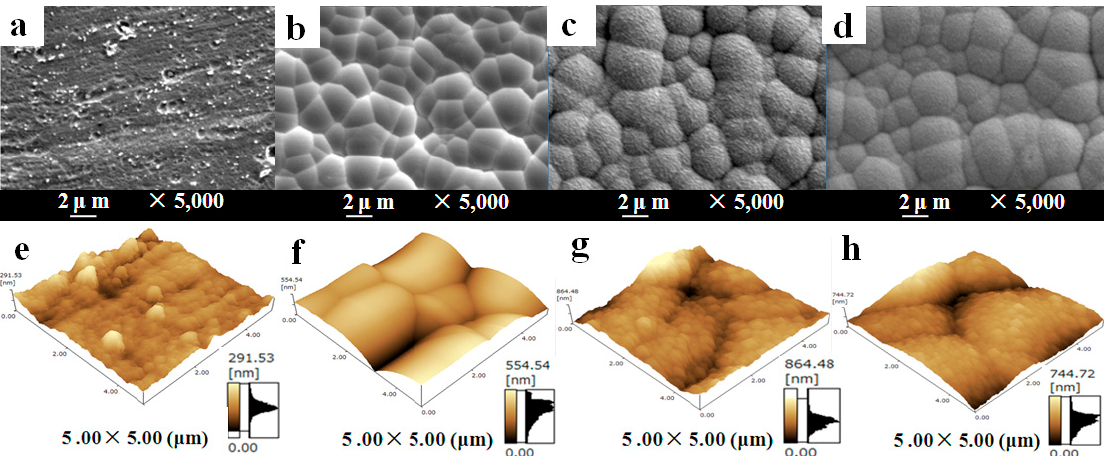
Figure 5. The SEM ( a – d ) and its corresponding atomic force microscope (AFM) ( e – h ) images. ( a – e ) bare aluminum alloy; ( b – f ) electroless Ni coating; ( c – f ) electrodeposited Ni–Co plating; ( d – h ) superhydrophobic